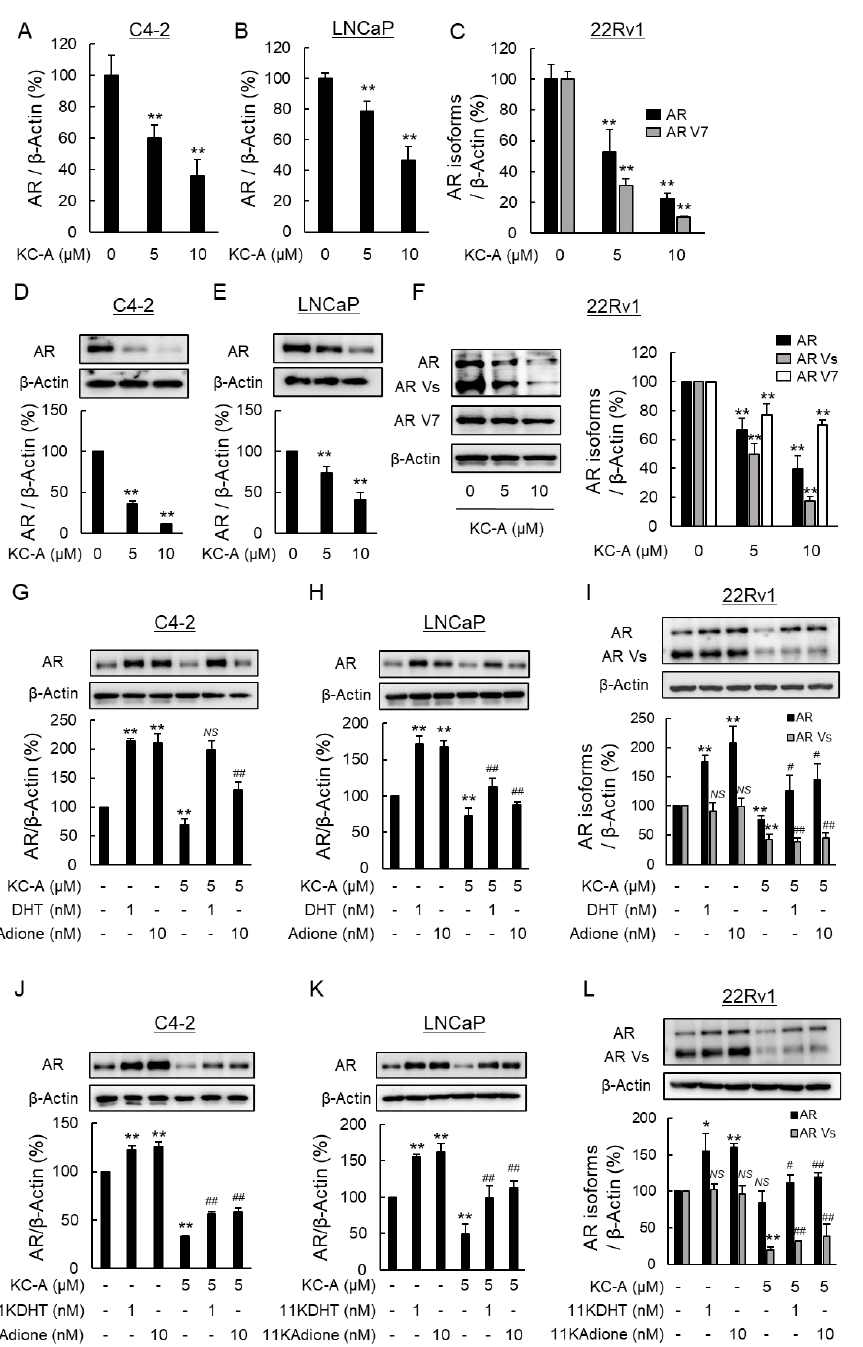
Figure 6. Effects of KC-A on AR expression in C4-2, LNCaP and 22Rv1 cells. ( A – C ) mRNA expression. The cells were treated for 24 h with the indicated concentrations of KC-A. The expression levels of the mRNAs for AR and AR V7 were analyzed by RT-qPCR. ( D – F ) AR protein expression. After 24 h-treatment of KC-A, the levels of AR, AR Vs and AR V7 in C4-2 ( D ), LNCaP ( E ) and 22Rv1 ( F ) cells were analyzed by immunoblotting ** p < 0.01 denotes significantly different from the cells treated with DMSO alone. ( G – L ) Effects of KC-A on AR expression induced by androgens. The cells were pretreated for 2 h without or with 5 μM KC -A, and then cultured for 24 h in the absence or presence of 1 nM DHT, 10 nM Adione ( G – I ), 1 nM 11KDHT or 10 nM 11KAdione ( J – L ). The protein expression levels of AR and AR Vs were analyzed by immunoblotting ** p < 0.01, * p < 0.05, NS p > 0.05 denotes significantly different from the cells treated with DMSO alone. ## p < 0.01, # p < 0.05, NS p > 0.05 denotes significantly different from the cells treated with DHT, Adione, 11KDHT or 11KA- dione alone.